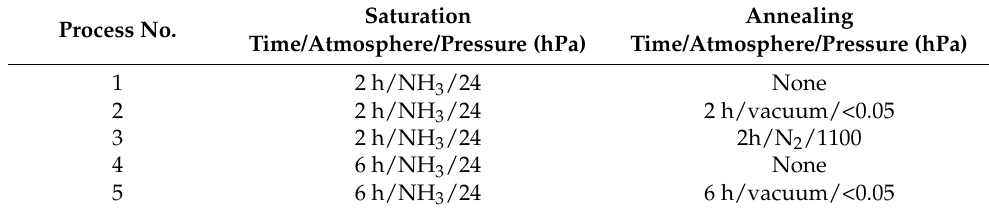
Table 2. Process parameters for low-pressure nitriding. Process